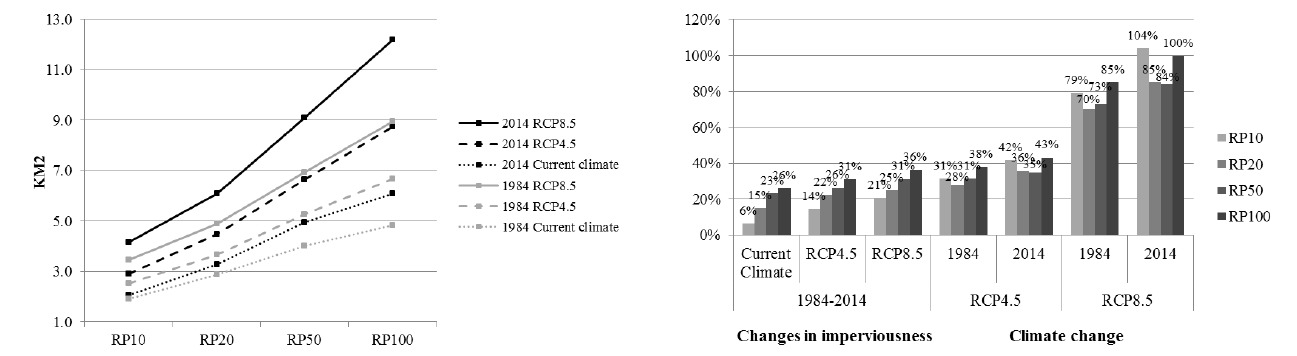
Figure 4. Effect of changes in imperviousness during 1984–2014 (32 → 51%) for current climate and in a RCP4.5 and RCP8.5 world, and impacts of climate change (RCP4.5, RCP8.5) for urban land cover as in 1984 (32% IS) and 2014 (51% IS) for total area flooded with >10cm of surface water during high-intensity precipi-